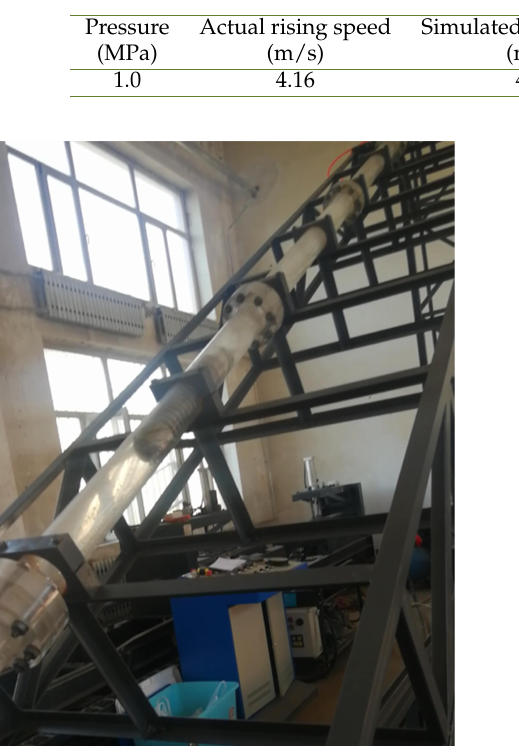
Fig. 17. Fluid drainage process of rotary plunger with 60 o inclination angle.